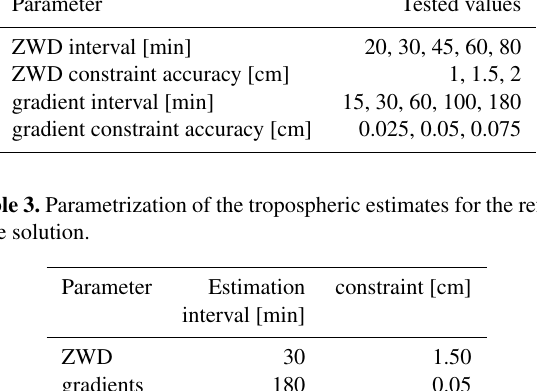
Figure 3. The average relative BLR change for a two-dimensional slice from the four-dimensional parameter space along the interval axes for constraints with 1.5 and 0.05cm for the ZWD and gradi- ents respectively. Blue color denotes improvement, red color degra-